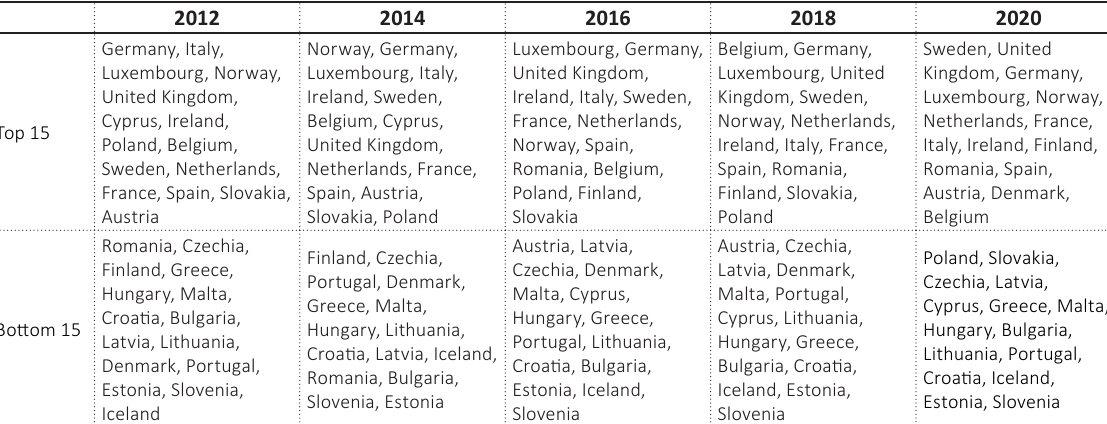
Table 2. The top 15 and bottom 15 (TI)